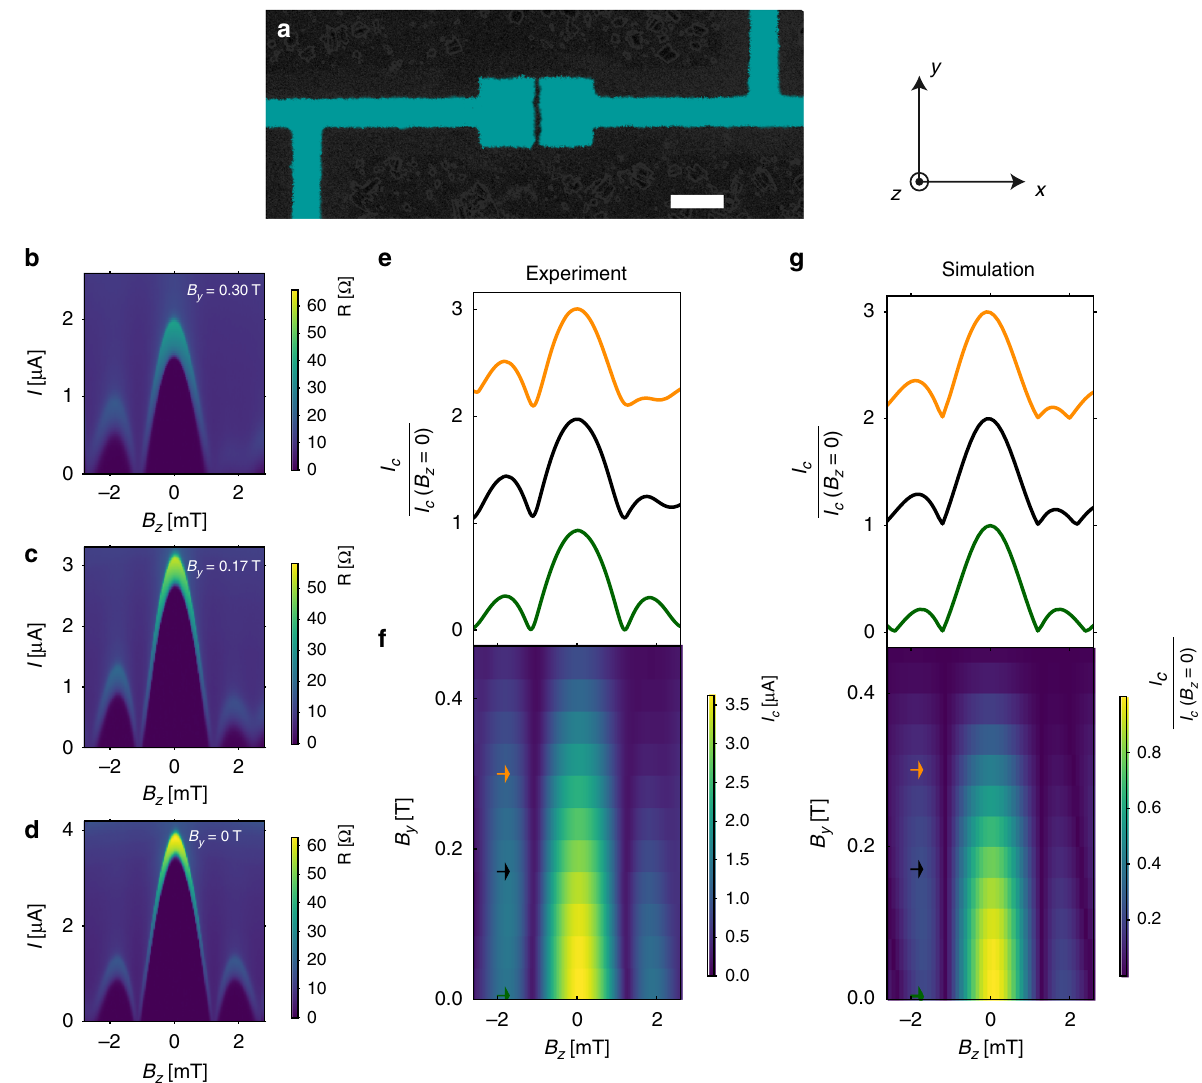
Fig. 3 Asymmetric Fraunhofer pattern. a SEM image of a single junction device with 20-nm-thick Aluminum electrodes. The scale bar is 2 μ m. The spacing between the two superconducting electrodes is L = 150 nm and the width of the junction W = 2 μ m. b – d Resistance maps as function of current and perpendicular magnetic fi eld B z , for different values of the in-plane magnetic fi eld B y . The corresponding critical current curves are shown panel e . At zero in-plane magnetic fi eld, panel d , the Fraunhofer pattern is symmetric with respect to B z . The pattern becomes asymmetric upon increasing B y . f Critical current map as a function of B z and B y showing the evolution from symmetric Fraunhofer pattern at B y = 0 to the asymmetric Fraunhofer pattern for B y >0. g Numerical simulation of the anomalous Fraunhofer pattern due to disorder and spin-orbit coupling. The model is described in the Supplementary Note 4